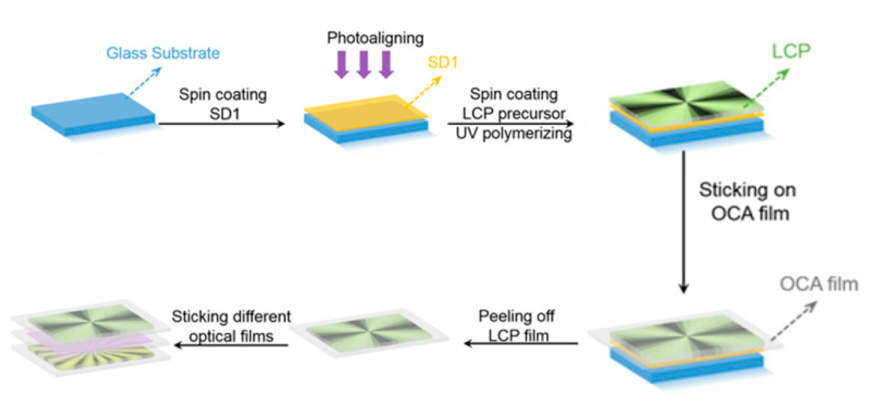
Figure 3. Flow diagrams of fabrication procedure of liquid crystal polymer (LCP) q-plate and assembling of different optical films [34].